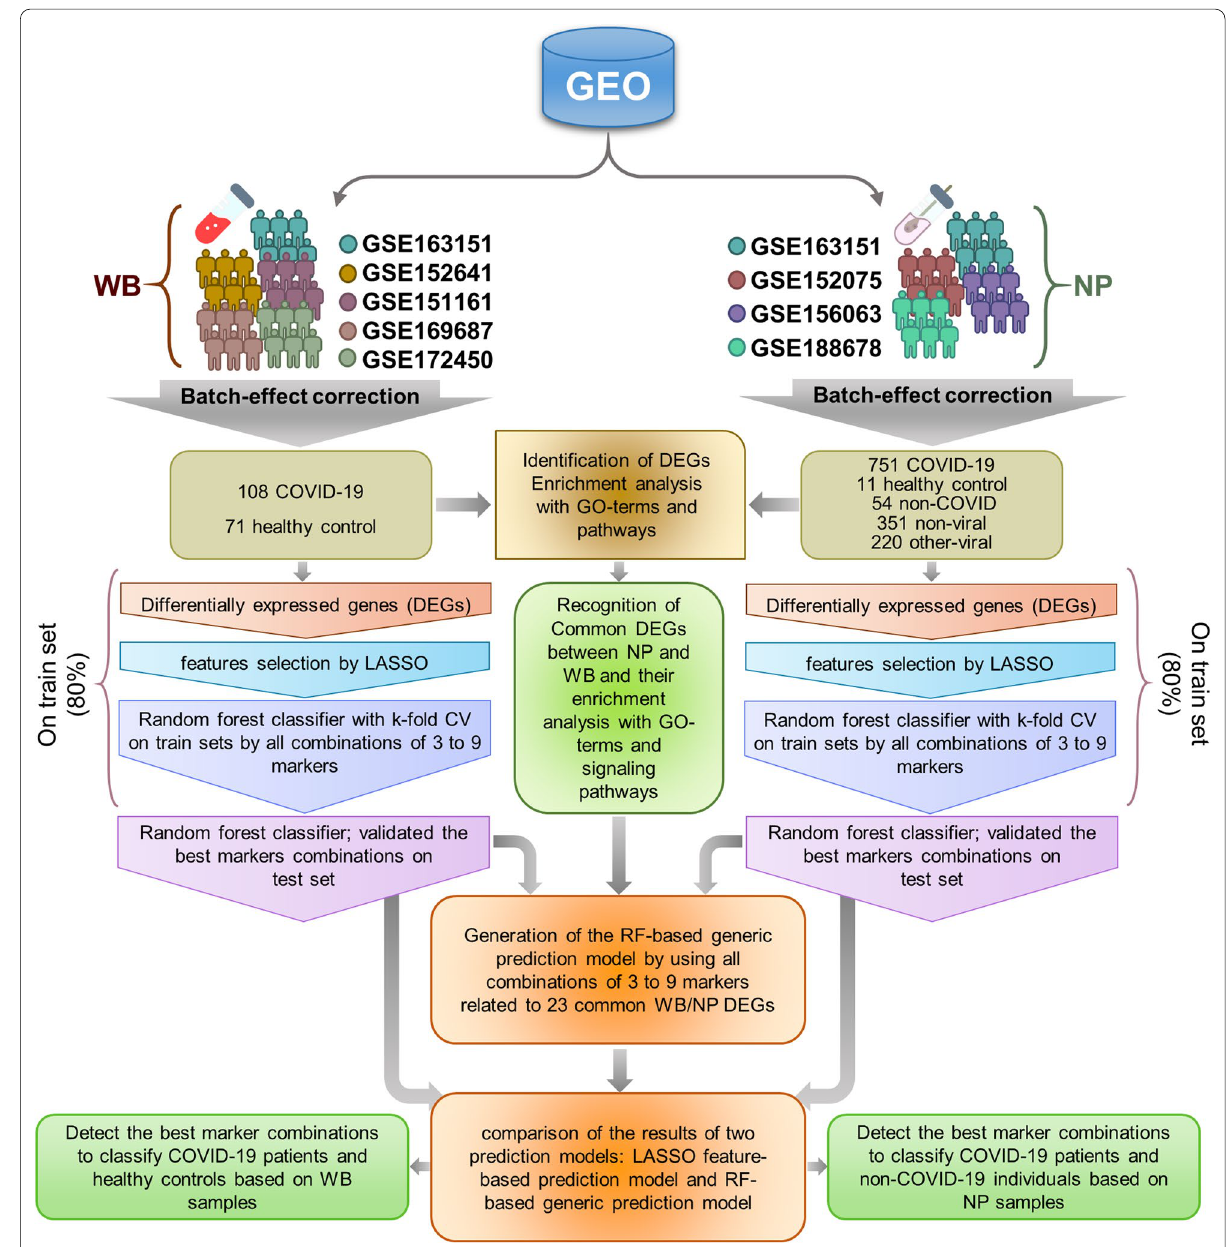
Fig. 1 The workflow of the study: The RNA-Seq datasets related to whole blood (WB) and nasopharyngeal (NP) samples from patients with COVID-19 infection and other similar disease conditions including viral and non-viral acute respiratory illnesses (ARI) as well as healthy controls were acquired from GEO database. Data were integrated and the batch effects were eliminated. Subsequently, the datasets were subjected to pathway enrichment and GO analyses. Furthermore, the candidate diagnostic biomarker panels were identified using machine learning methods on train datasets and validated on independent cohorts to introduce the best biomarker combinations. Besides, the RF-based generic prediction models were generated by using all combinations of 3 to 9 markers related to 23 common WB/NP DEGs was done. Finally, the results of two prediction models, including the LASSO feature-based prediction model and RF-based generic prediction model were compared. WB whole blood, NP nasopharyngeal, ARI acute respiratory illnesses, RF random